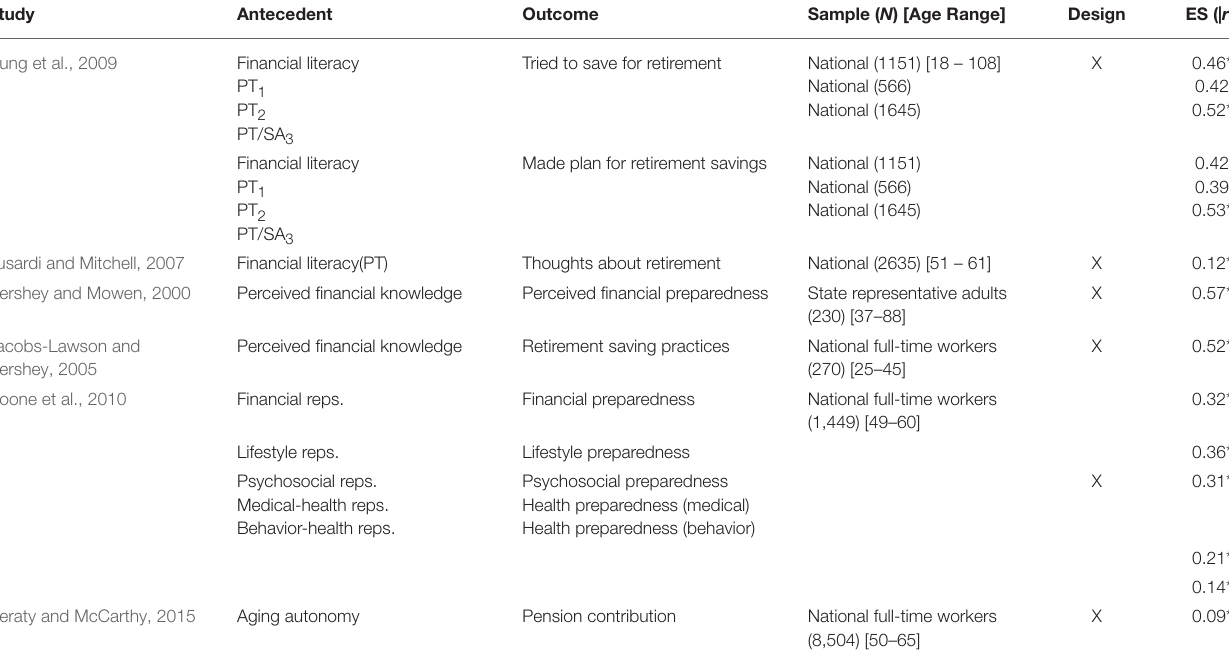
TABLE 2 | Summary study descriptives and effect sizes for cognitive individual difference antecedents of retirement